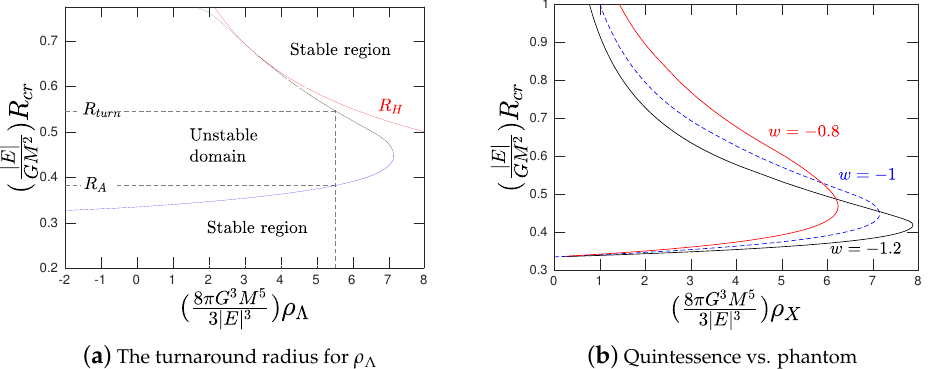
Figure 1. ( a ): Thermodynamic equilibria of an ideal gas cannot exist below the turnaround radius R turn for a fixed energy E . We assume here a dark energy density with the equation of state corresponding to the cosmological constant Λ . Its value can be estimated by this framework if one considers the typical energy of a perturbation and the smaller bound structures observed. Conversely, assuming the Λ value is measured by other means, this framework predicts the bigger gravitationally bound structures than may exist in the Universe. At even smaller scales, R < R A stability is restored, and stable equilibria do exist. Note that the turnaround radius predicted here thermodynamically is stricter and more accurate than the R H predicted considering only homogeneous equilibria. The figure is taken from [8]. ( b ): We consider a quintessential type of dark energy w = − 0.8 and a phantom type of dark energy w = − 1.2. It is evident that the unstable domain is reduced for the phantom case. Therefore, quintessence favors the formation of structure w.r.t. the phantom dark energy and the cosmological constant. The figure is taken from